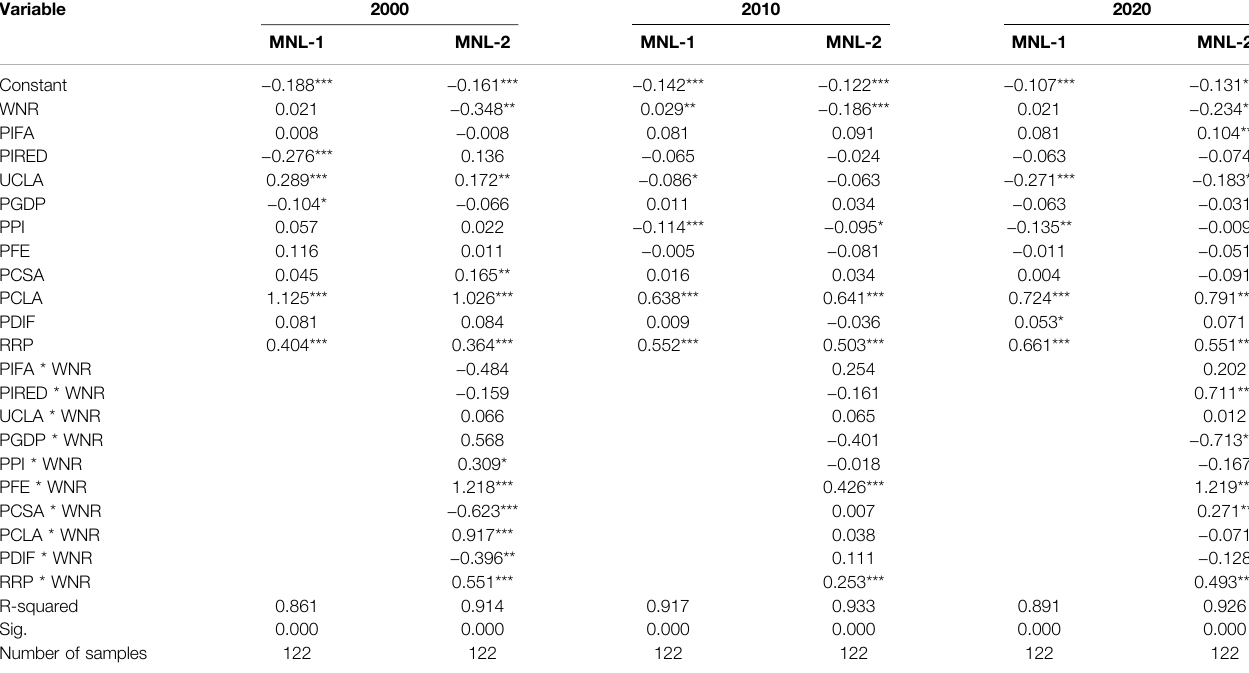
TABLE 4 | Ordinary least-squares regression results of in fl uencing factors of RRL.